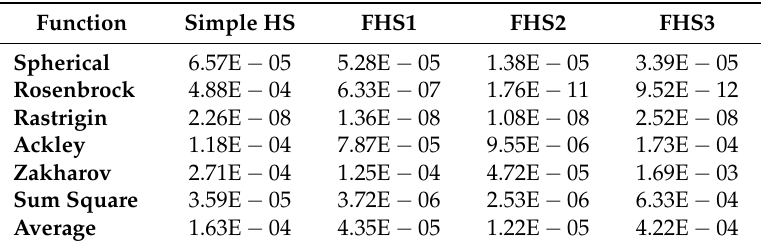
Table 12. Comparison of results obtained with all the proposed methods.